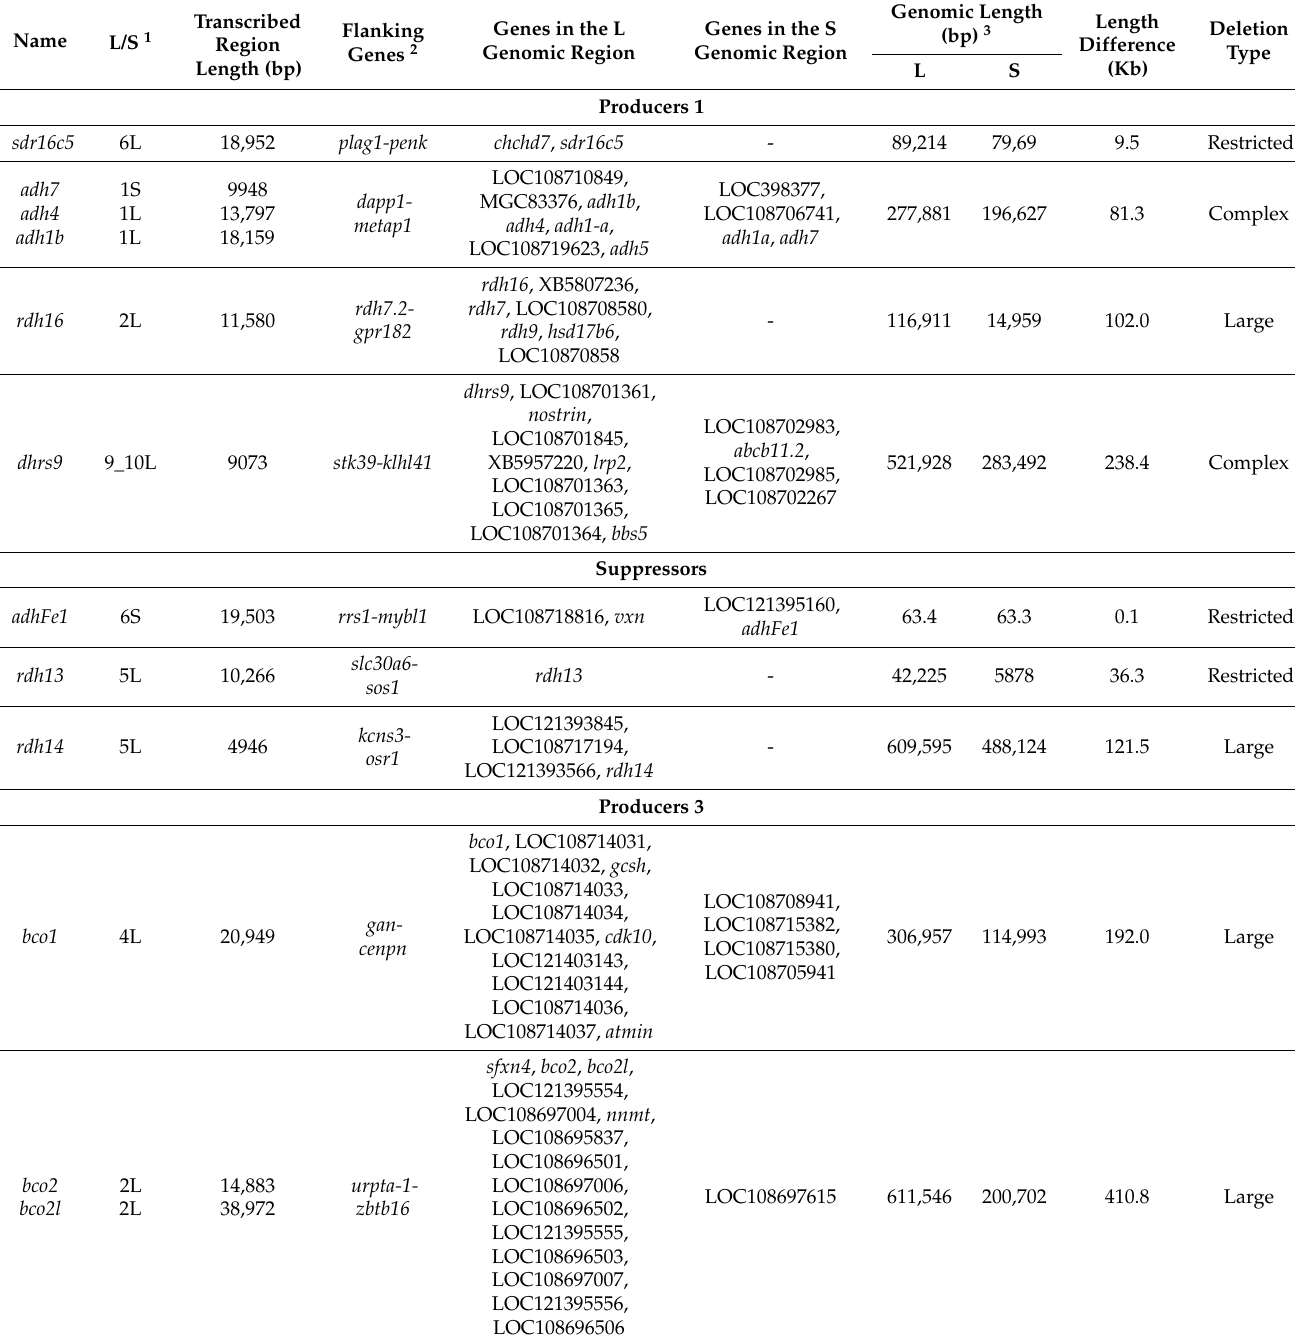
Table 3. Genomic changes in the generation of RA network